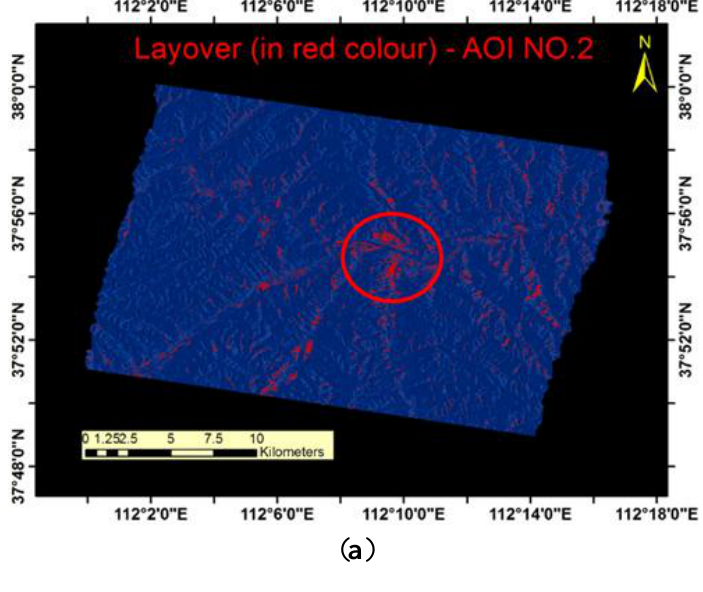
Figure 14. The 4-D TomoSAR result at area with serious layover phenomenon. ( a ) is the layover map of AOI NO.2 defined by a red circle; red color indicates layover effect. ( b ) indicates two objects in AOI NO.2. ( c ) shows the subsidence of signal scatter, and ( d ) and ( e ) show the subsidence of double scatters of the playground. ( f ) shows the subsidence of signal scatter and ( g ) and ( h ) show the subsidence of double scatters of the business quarter. Note that ( a ) was flipped and